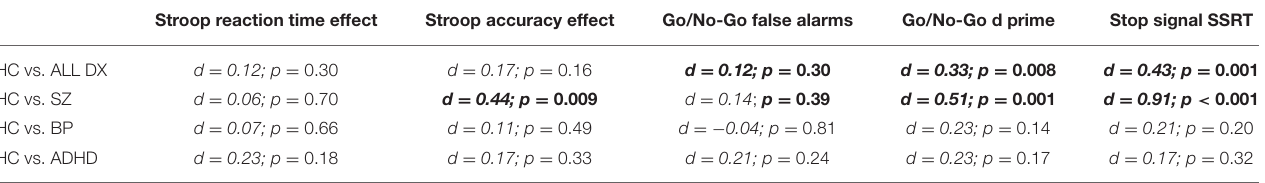
TABLE 3 | Relationship between standard dependent measures in three behavioral tasks and measures of